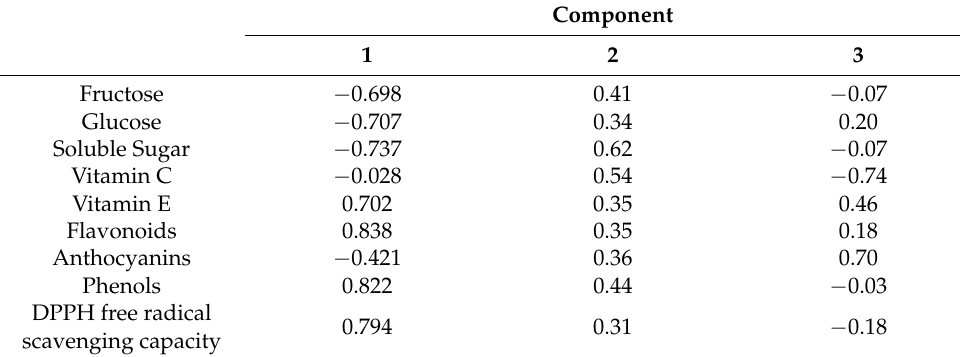
Table 3. Loading coefficients of each principal component.